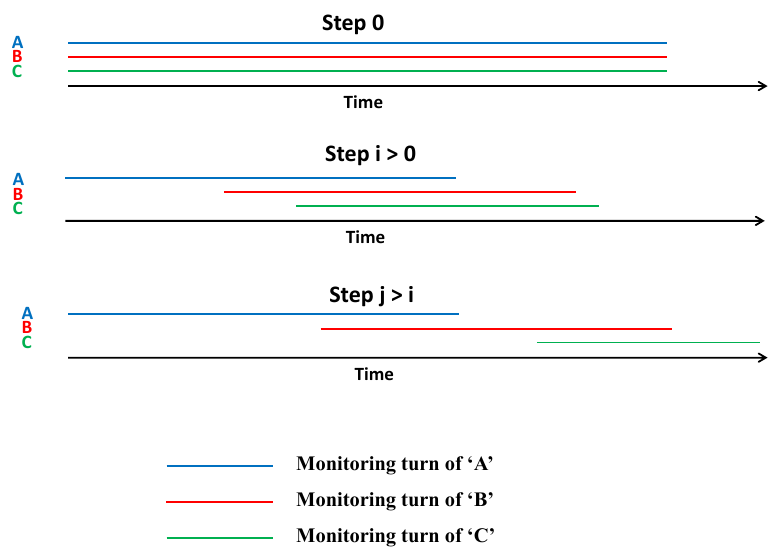
Figure 5. Convergence of our trust-based time division distributed monitoring technique.